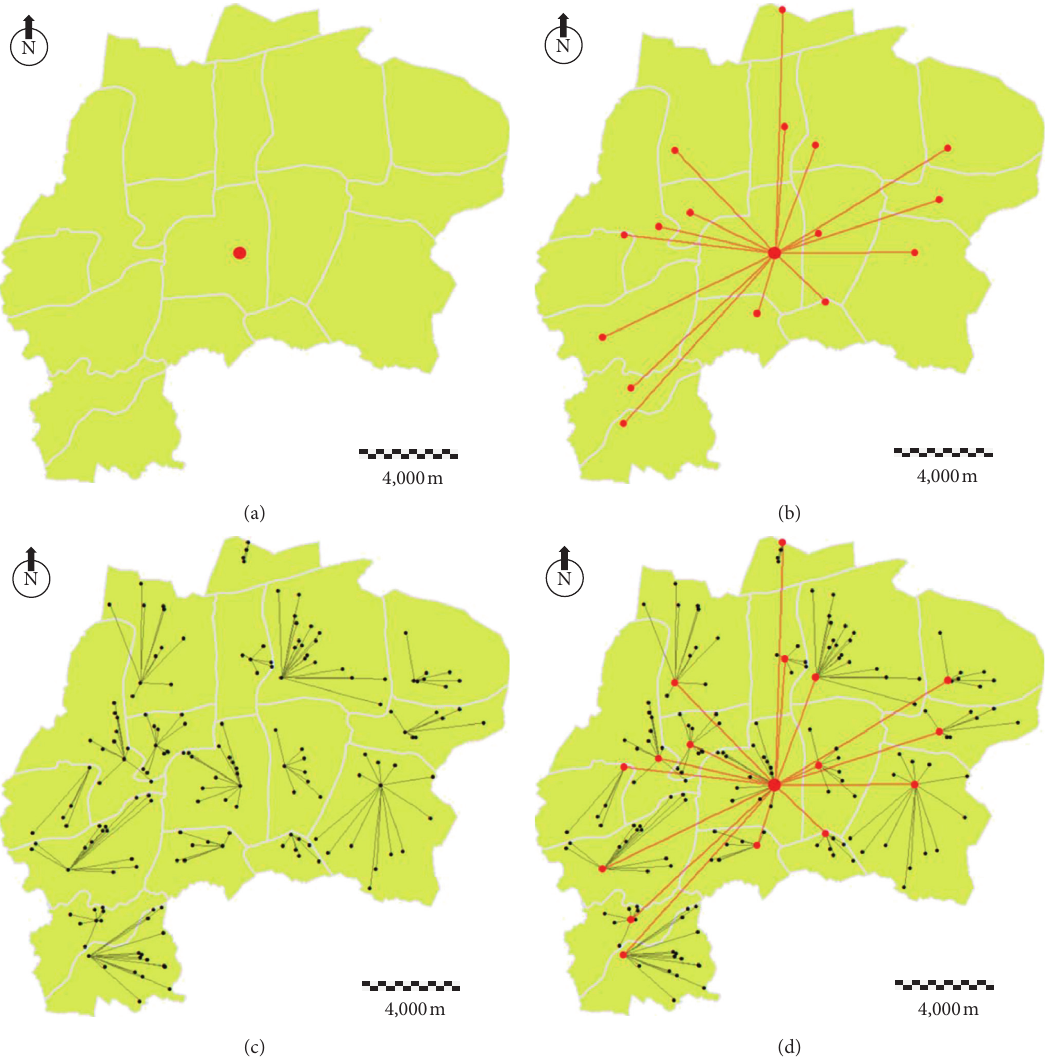
Figure 2: Implementation of the spatial network according to 2015 census data. (a) The most populated settlement for the whole study area is represented by a red node. This node is the central hub of the whole network. (b) A first-order network is established by linking this central hub with the most populated settlement in each parish. (c) A bunch of second-order networks is established by linking the most populated settlement in each parish with all the settlements within this same parish. (d) The final network results from merging the first-order and second-order spatial